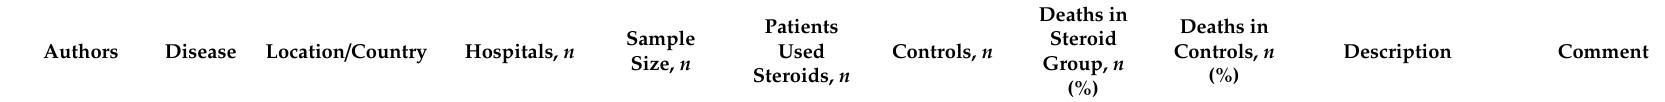
Table 1. Main characteristics and findings of the studies included in the